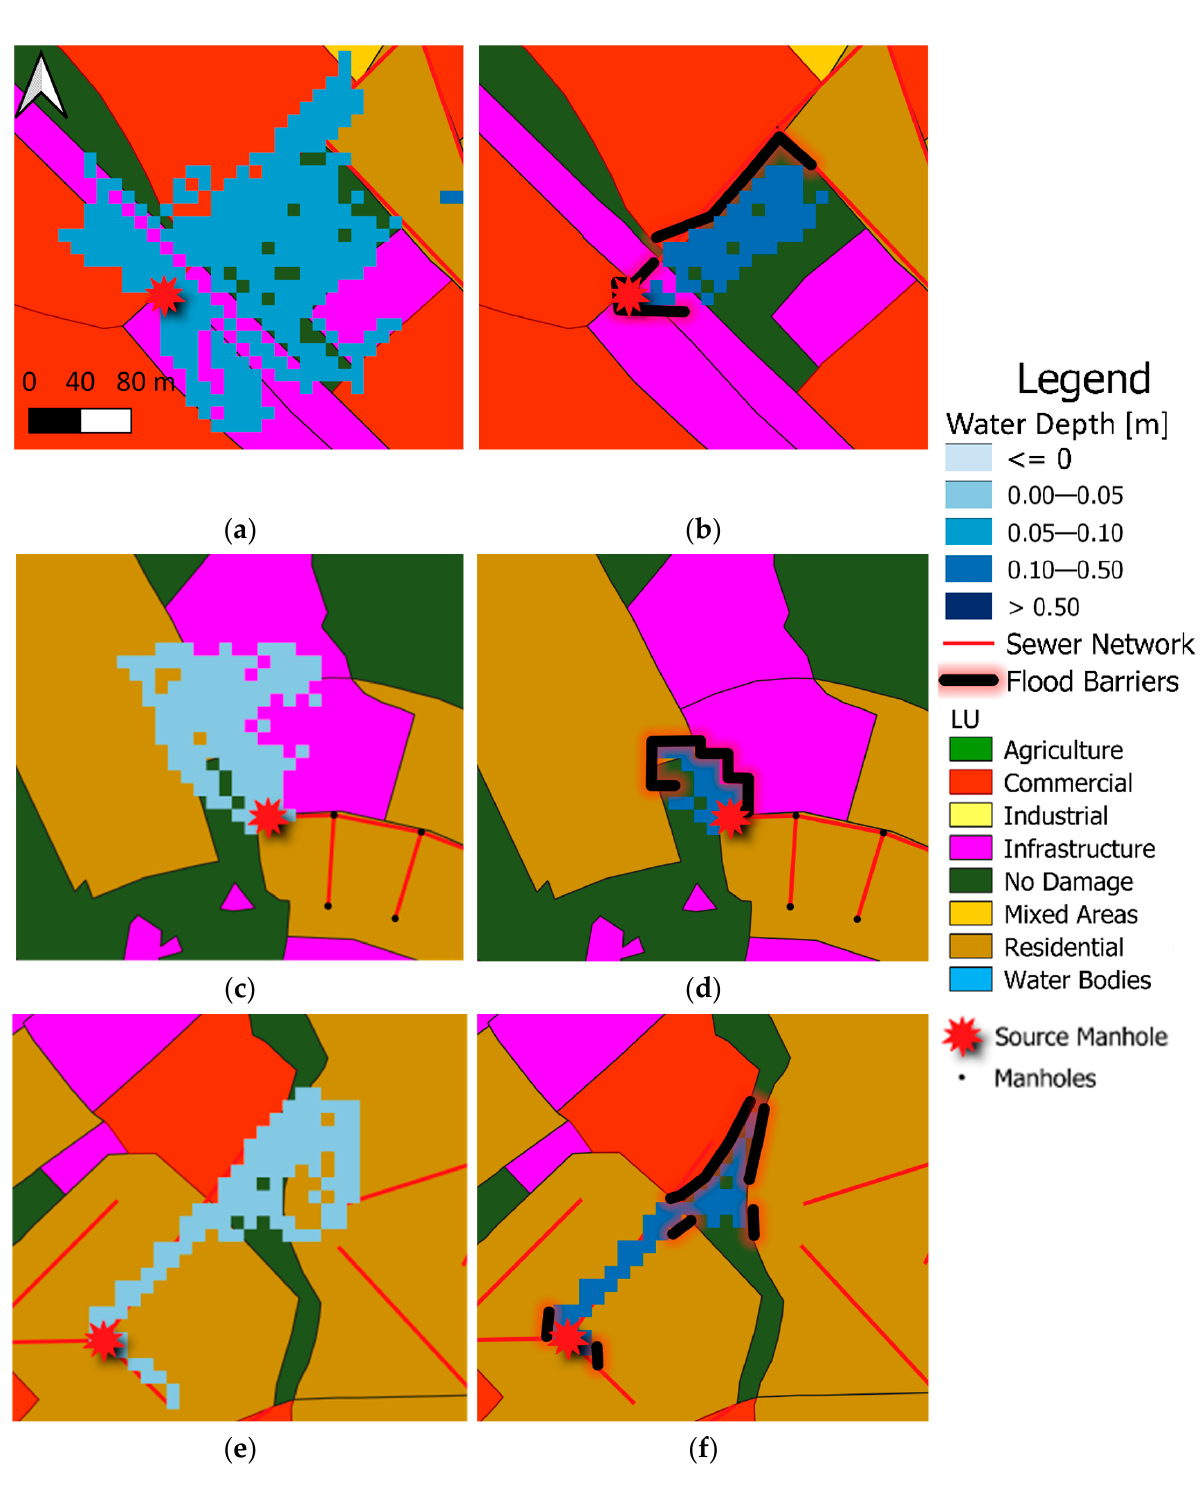
Figure 8. Final flood extents propagation in GAMA for different manholes of a design storm event with 100-year return period. ( a ) Manhole “17G25” without flood barriers; ( b ) Manhole “17G25” with flood barriers; ( c ) Manhole “39K169” without flood barriers; ( d ) Manhole “39K169” with flood barriers; ( e ) Manhole “17H120” without flood barriers; ( f ) Manhole “17H120” with flood barriers.